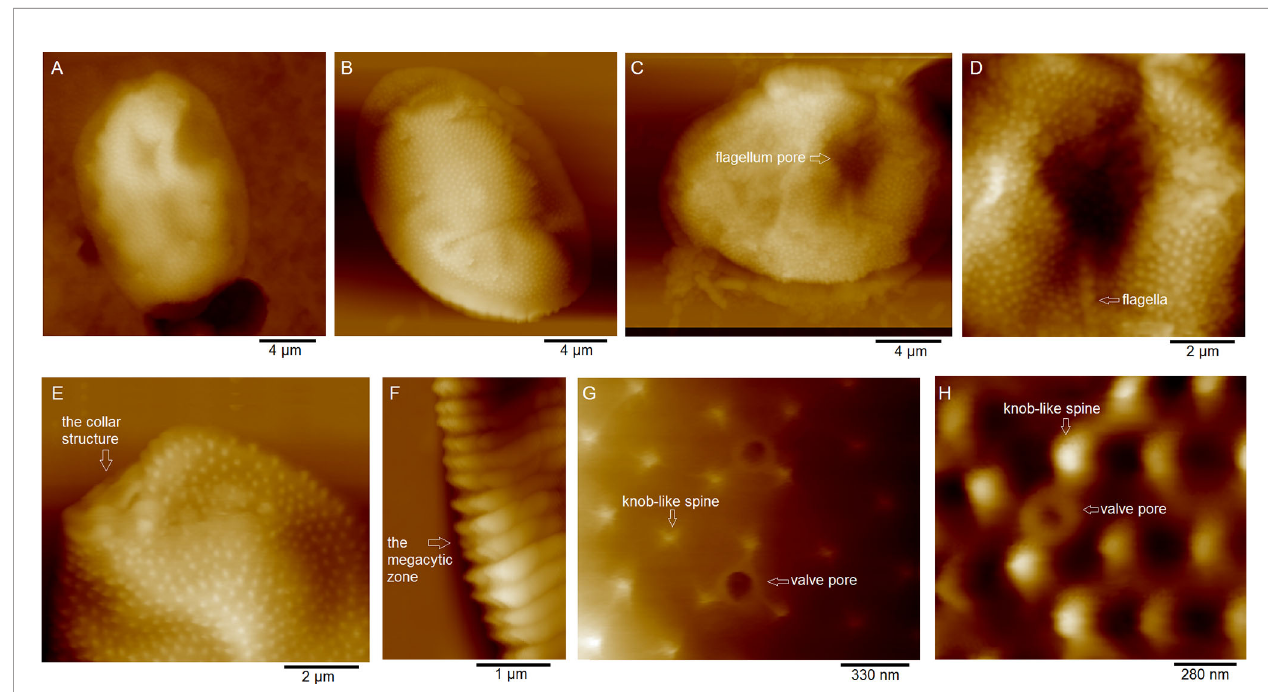
FIGURE 1 | Images of P. donghaiense by AFM. (A) Valve view. (B) The left valve view. (C) Lateral view of cell which shows the fl agellum pore. (D) Lateral view of cell which shows the fl agellate. (E) The local magni fi cation of cell which shows the collar structure. (F) The local magni fi cation of cell which shows the megacytic zone. (G, H) The ultrastructure of the cell surface, which displays typical structures, such as knob-like spines and valve